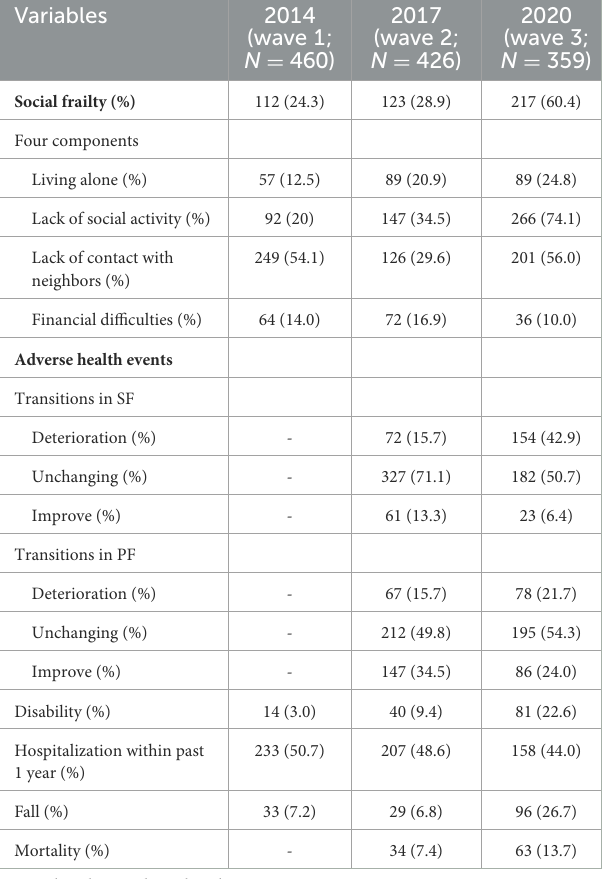
TABLE 2 The overall social frailty status and adverse health events of participants at each